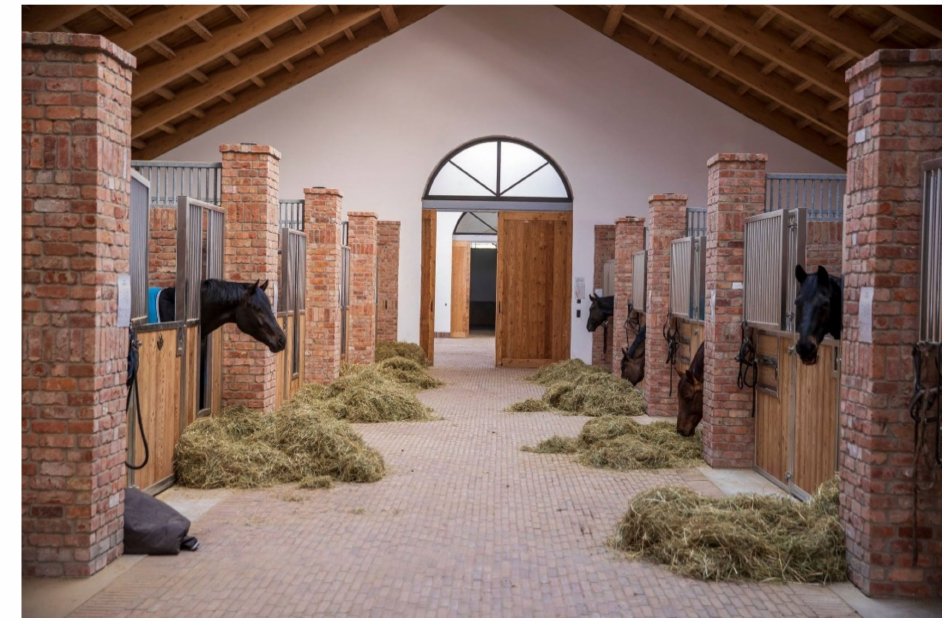
Figure 4. Social stall. Gut Schönweide,